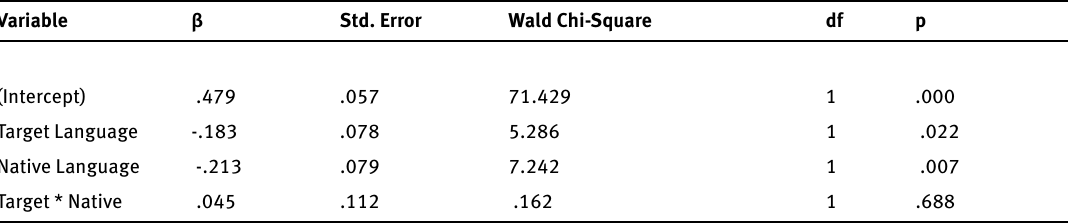
Table 7 Logistic Regression of novel words – all